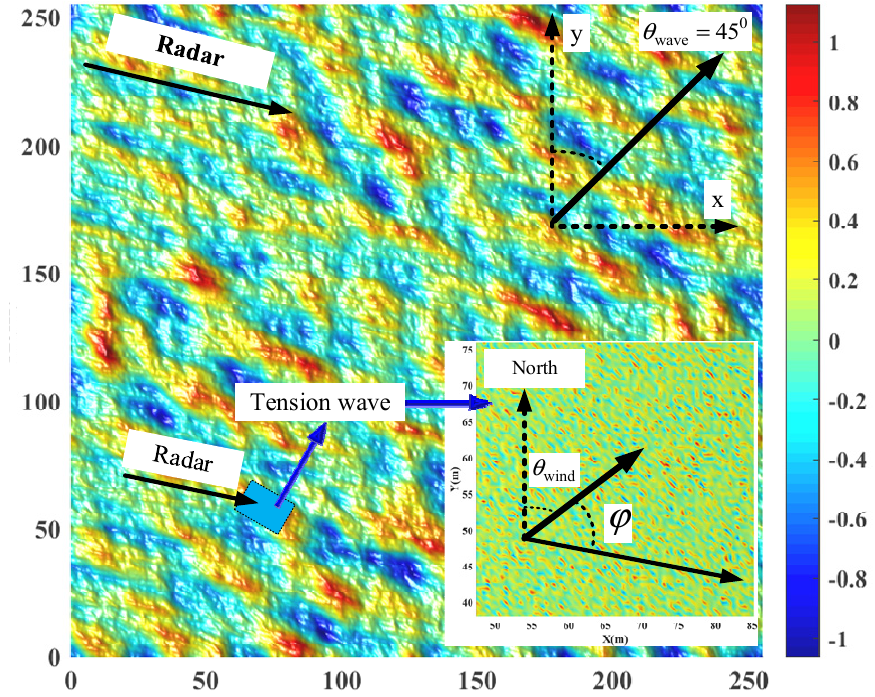
Figure 3. EM scattering mechanism of radar-illuminated sea surface.